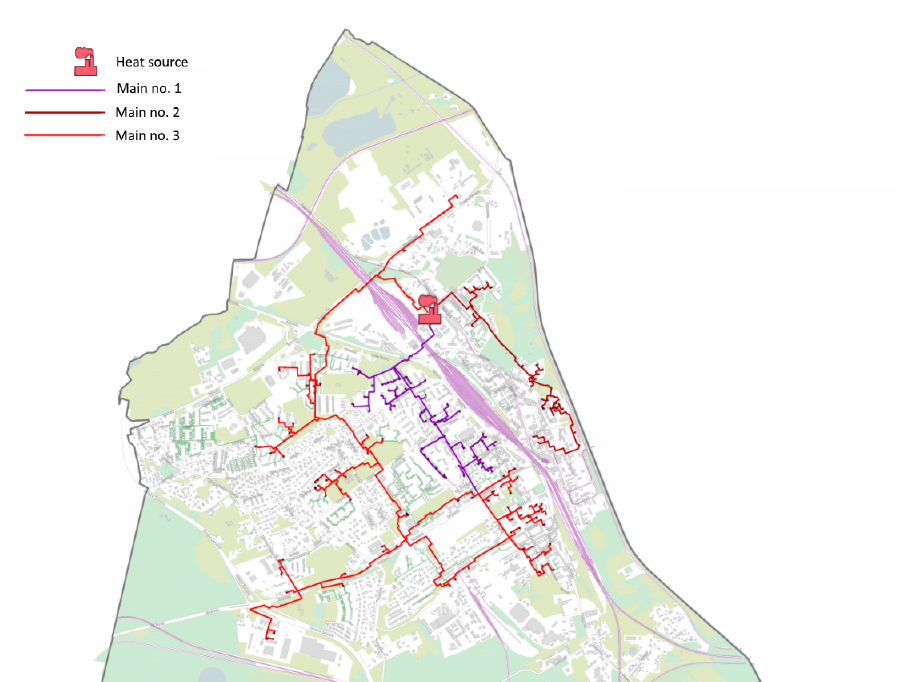
Figure 2. Map of analyzed district heating